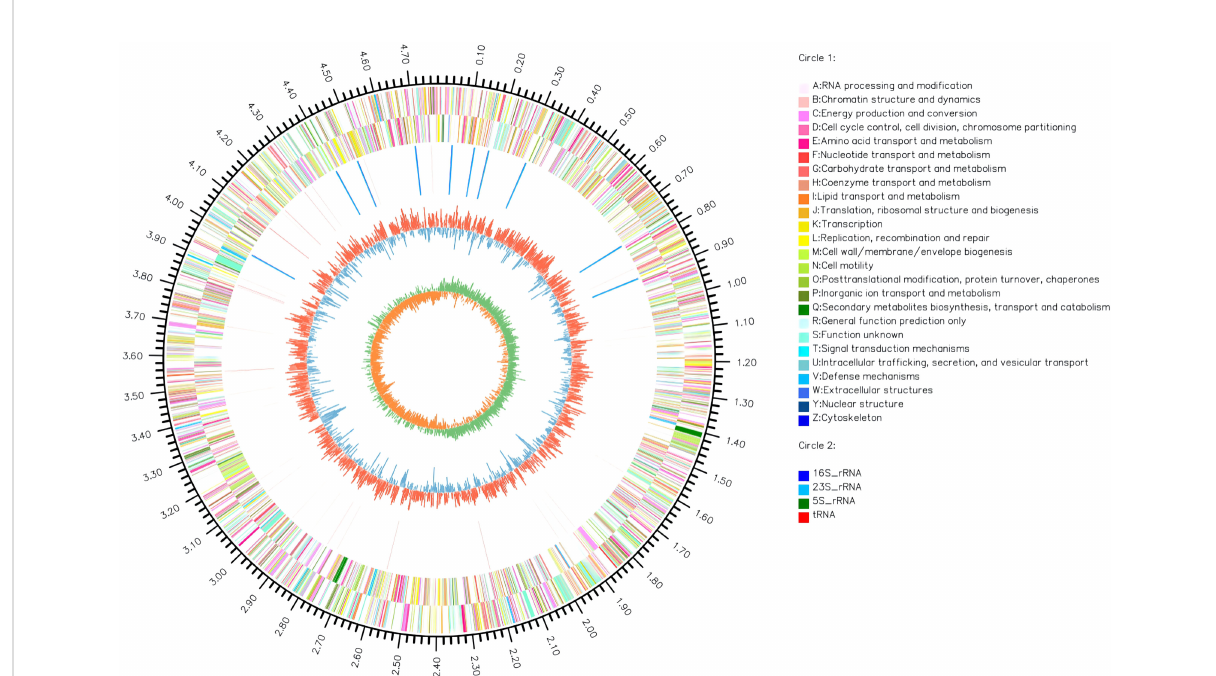
FIGURE 2 Circos circular map of A. hydrophila MX16A genome. The outer circle indicates the size of the genome, every scale represents 0.5 Mb; The second and third circles represent the CDS from positive-sense and negative-sense strand of genome sequences, different colors represent various functions of COG; The fourth circle represents tRNA and rRNA; The fi fth circle shows the (G+C) content, the outer red portion indicates that the GC content of the region is higher than the average GC content of the whole genome; higher peaks indicate a larger difference with the average GC content; the inner blue signals indicate that the GC content of the region was lower than the average GC content of the whole genome; higher peaks indicate a larger difference with the average GC content; the innermost circle shows the GC-Skew value. The innermost circle features the GC-Skew value, the speci fi c algorithm was (G-C)/(G+C), useful to determine the leading strand and lagging strand. In general, the leading strand GC features skew>0, the lagging strand GC features skew<0. This may further help to determine the replication starting point and the cumulative offset may also assist in determining the starting point, i.e. cumulative offset minimum, and the end point, i.e. cumulative offset maximum, of replication, particularly important for cyclic genomes.